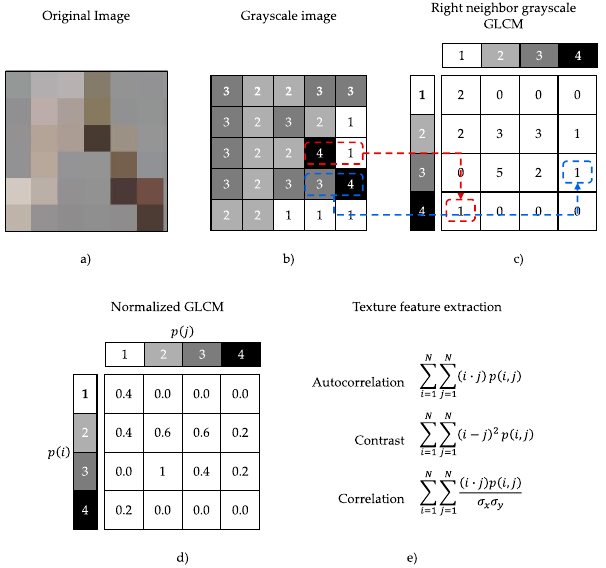
Figure 8. GLCM procedure to determine the co-occurrence matrix of gray intensity levels. ( a ) RGB image, ( b ) gray intensity levels of the RGB image, ( c ) GLCM co-occurrence matrix of the gray intensity levels, ( d ) normalized GLCM matrix between 0 and 1, ( e ) texture equations extracted from the normalized GLCM matrix. GLCM starts with the transformation of an original image in RGB to a grayscale im- age, represented in Figure 8a,b. In the second step, an occurrence matrix 𝑀(𝑖,𝑗) is created, Table 2. Notation for the calculation of Haralick texture features. Source: [33]. i.e., the values at the positions in (𝑖,𝑗) represent the number of times the gray level inten- sity value 𝑖 is a neighbor of the gray level intensity value 𝑗 , as we showed in Figure 8c. After obtaining the occurrence matrix, 𝑀(𝑖,𝑗) , the values (𝑖,𝑗) are normalized, as shown in Figure 8d. Finally, the resulting matrix 𝑝(𝑖,𝑗) is suitable for the application of the Haralick texture features (Figure 8e). Table 2 shows the notation of the variables involved